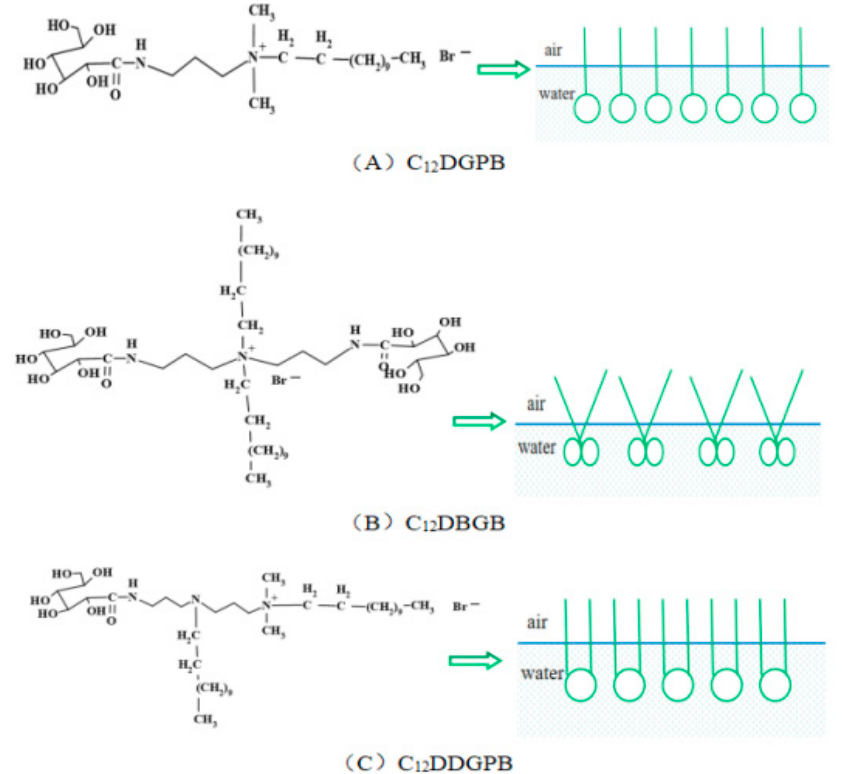
Figure 2. Molecular interface arrangement of ( A ) C 12 DGPB, ( B ) C 12 DBGB, and ( C ) C 12 DDGPB.